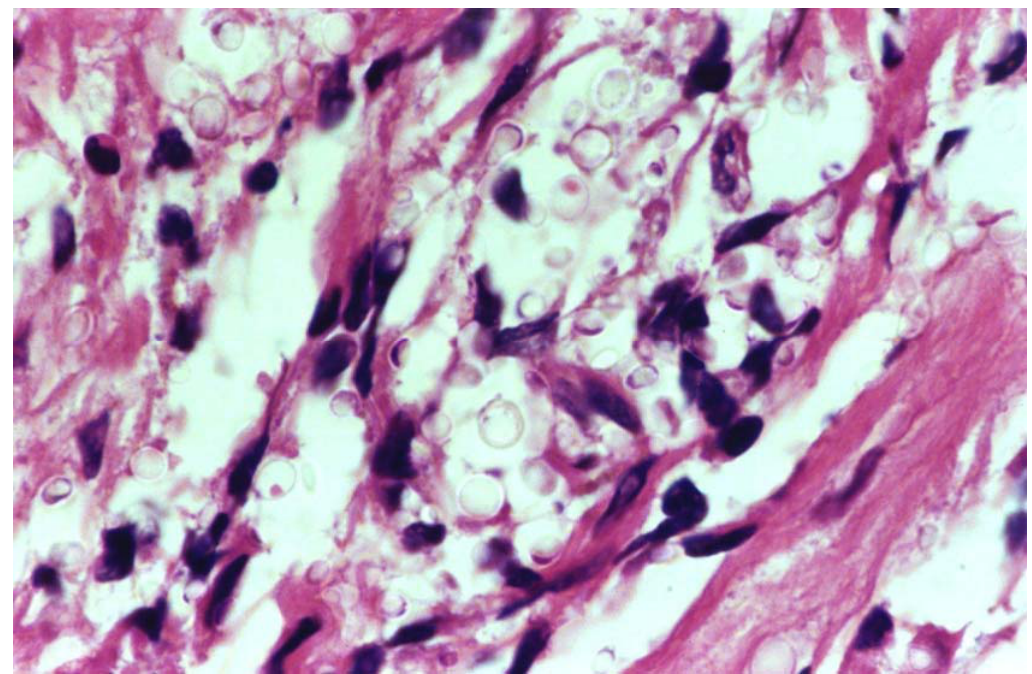
Figure 1. Histological section of prostate, presenting a great number of yeast-like structures, with no inflammatory reaction (HE 1000X)